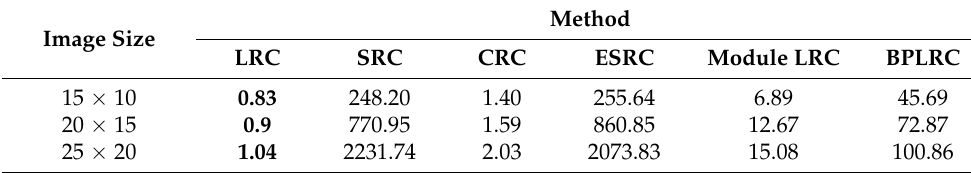
Table 6. Computational time (seconds) for different methods to identify 1254